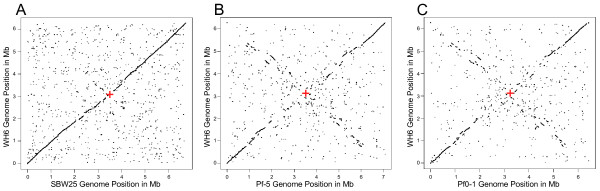
Synteny plots comparing the organization of the WH6 genome to that of the three other isolates of P. fluorescens. Unique 25 mers from P. fluorescens isolates SBW25 (A), Pf-5 (B), and Pf0-1 (C) were compared to the improved, high quality draft genome sequence of WH6. The start positions of all matching pairs were plotted in an XY graph with the coordinates of the genomes of SBW25, Pf-5, and Pf0-1 along the x-axis and coordinates of the genome of WH6 along the y-axis. The termini are located at the approximate mid-way point for each comparison (red +). Genome scales are shown in one Mb increments.